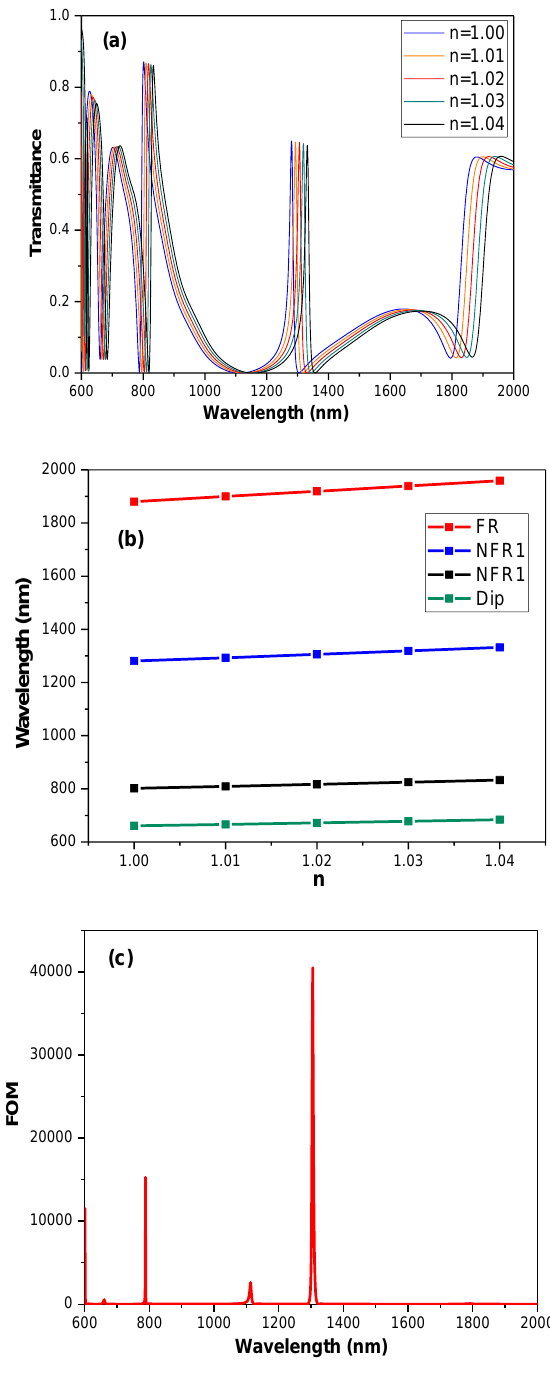
Figure 6. ( a ) The transmission spectra of the triple Fano resonances structure with variable n from 1.0 to 1.04. ( b ) The resonant wavelengths of Dip, NFR1, NFR2 and FR with variable n. ( c ) The figure of merit (FOM) with different wavelengths of the triple Fano resonances structure.